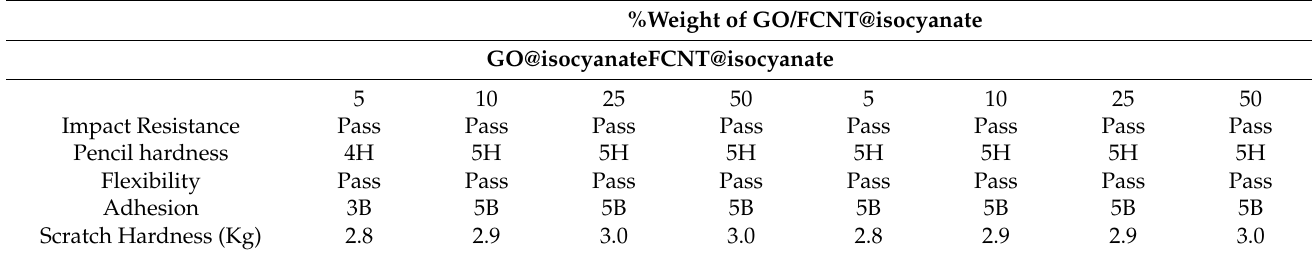
Table 1. Mechanical properties of polymer films with various %wt of GO/FCNT@isocyanate.